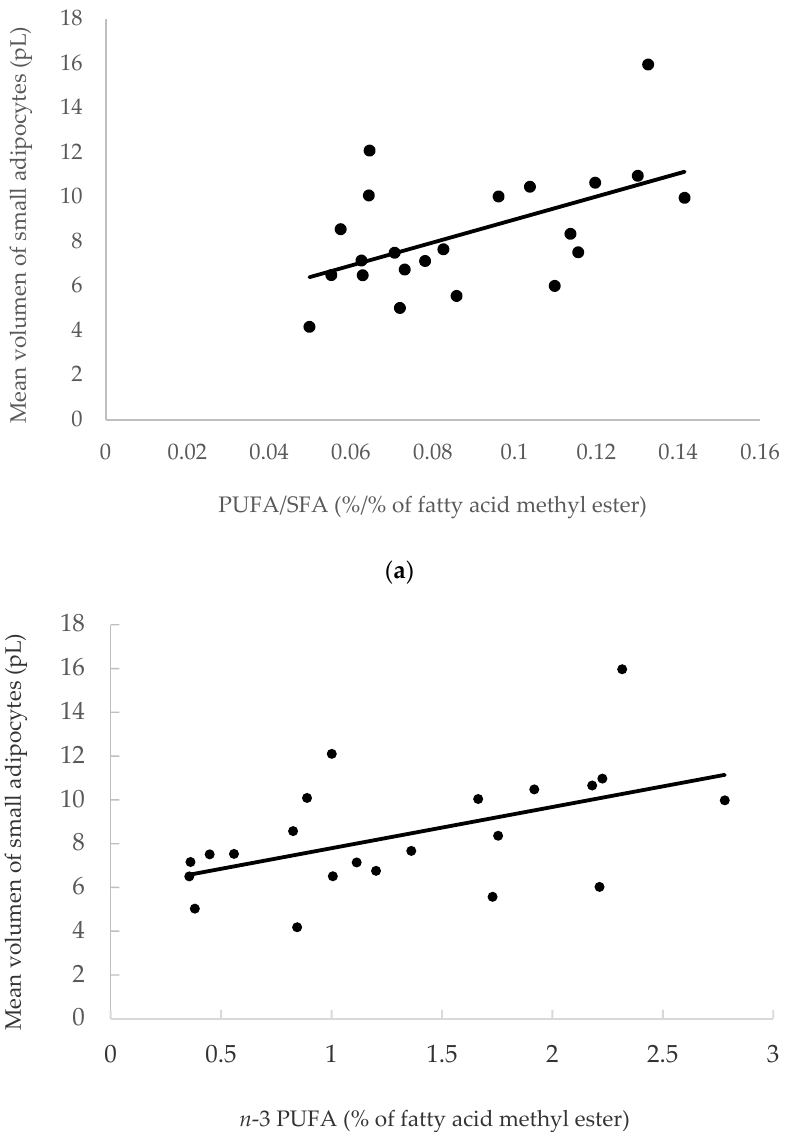
Figure 6. (a) Positive correlation between PUFA / saturated fatty acids (SFA) and mean volume of small adipocytes in the subcutaneous (SC) adipose tissue (AT) ( r = 0.539; p = 0.0097); ( b ) positive correlation between n -3 PUFA and mean volume of small adipocytes in the SC AT ( r = 0.512; p =